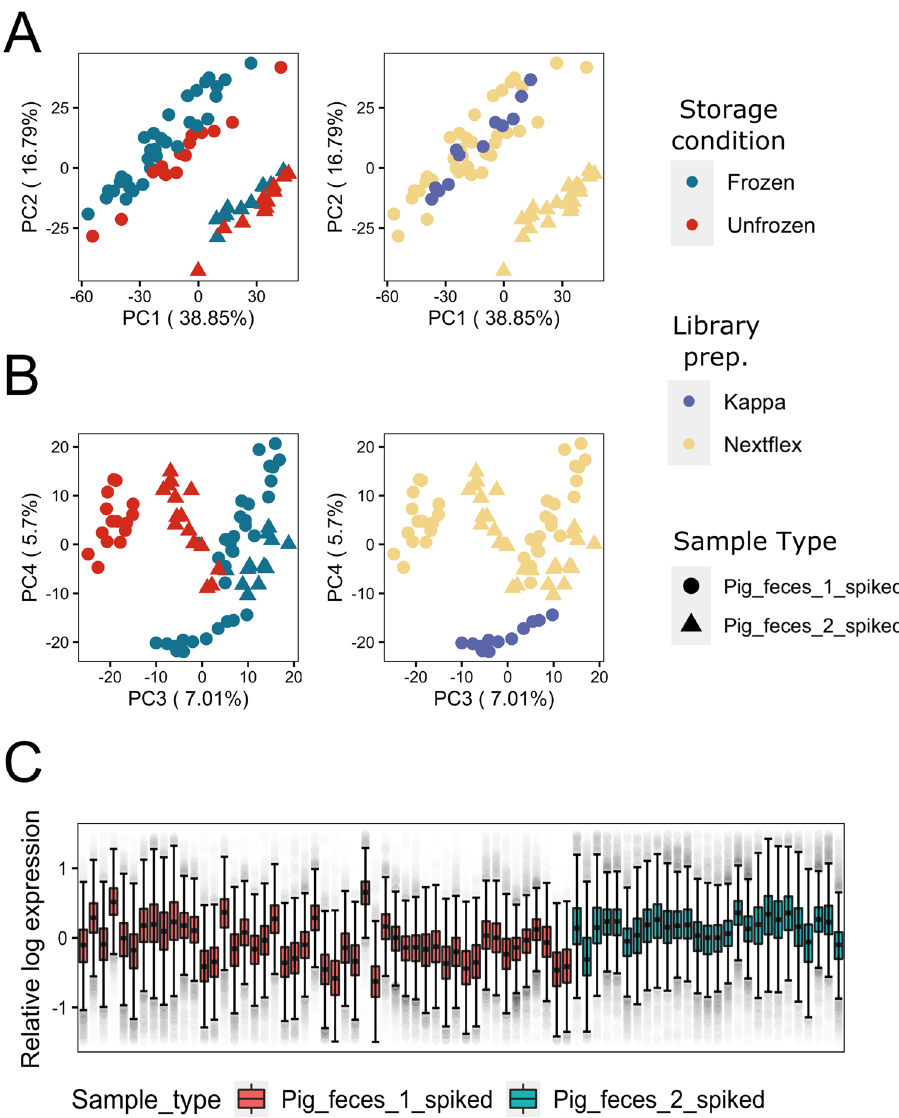
Figure 2. Visualizations of the CLR-normalized data of all spiked samples: (A) Principal component analysis (PCA) plots showing sample clustering based on sample origin (pig1 vs pig 2) explained by PC1 and PC2, while (B) separation of samples based on storage conditions and library preparation kits used were explained by PC3 and PC4, respectively. (C) Relative log expression (RLE) plot of all spiked samples, showing considerable variations based on deviation of the medians between samples of the same source, as well as dissimilarity of interquartile ranges (IQR)